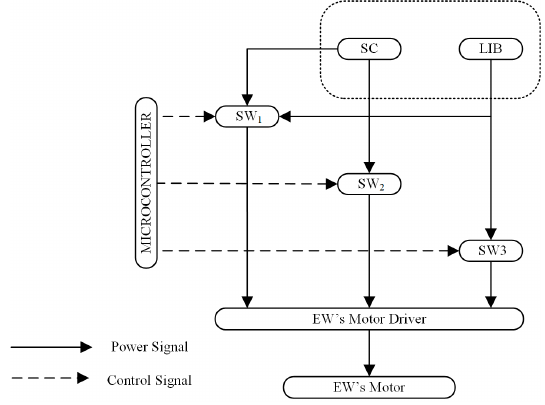
Figure 6. Hardware implementation of the SEMS algorithm.